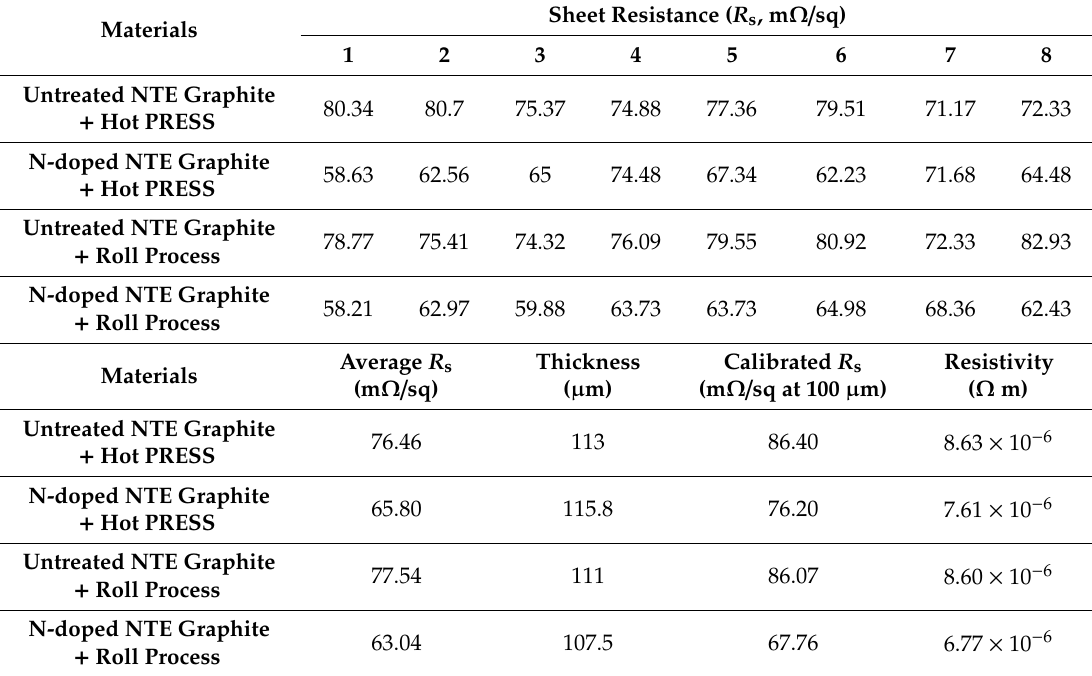
Table 4. Resistance values of the sheets derived from untreated NTE graphite and N-doped NTE